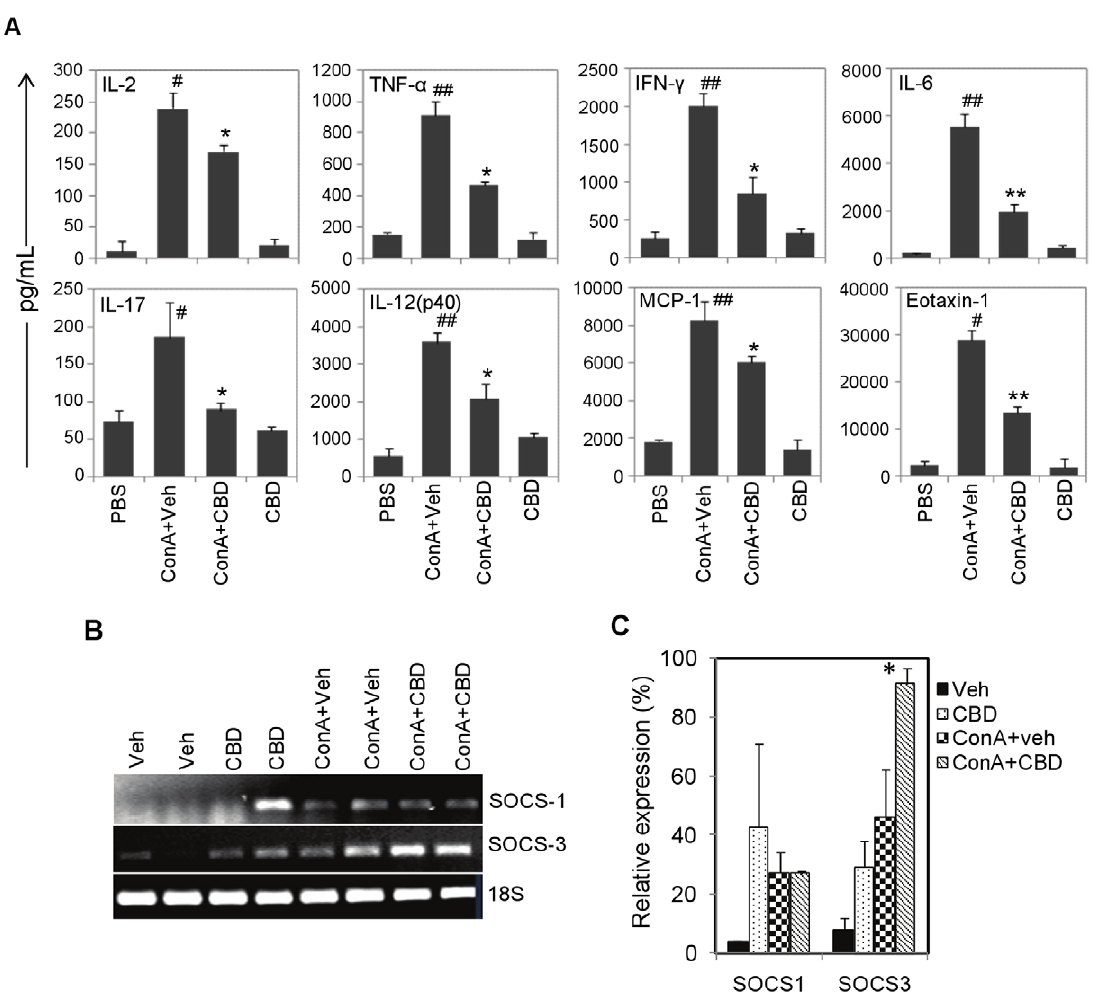
Figure 2. Analysis of inflammatory cytokines, SOCS1 and SOCS3. A) CBD acts by suppressing pro-inflammatory cytokines in ConA-induced hepatitis. WT mice (n=6) were injected with PBS or ConA. ConA injected mice were administered with vehicle or CBD (25 mg/kg bd.wt.). CBD group received CBD alone at 25 mg/kg bd.wt. Blood was collected after 12 h and serum cytokines were determined by Bioplex assay. Error bars represent mean 6 SEM (n=6). The data were analyzed by Student’s t -test ( ## p , 0.01 compared to PBS; *p , 0.05, **p , 0.01 compared to ConA + Veh). B) Semi- quantitative RT-PCR for SOCS-1 and SOCS-3 in livers 2 h after various treatments in vivo . 18S was used as a loading control. C. The densities of bands were quantified using gel imaging system (BioRad) and expressed as percentage expression relative to 18S. Student’s t -test, *p , 0.05 compared to ConA. MDSC (Fig. 5A). In some wells with T cell: MDSC ratio of 10:1,